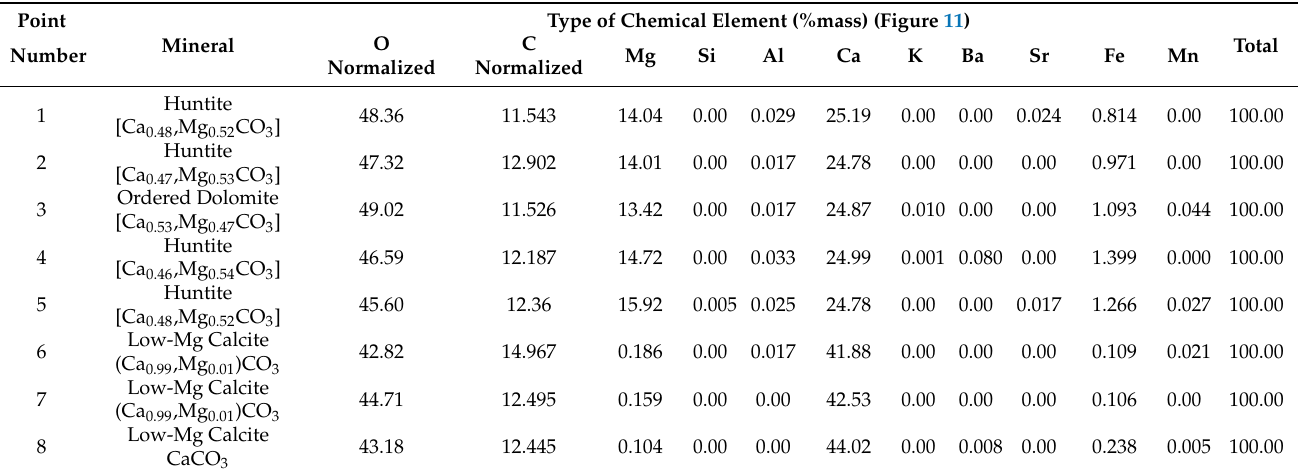
Table 2. Results of the microprobe measurements of a sample SO14 [22,24].